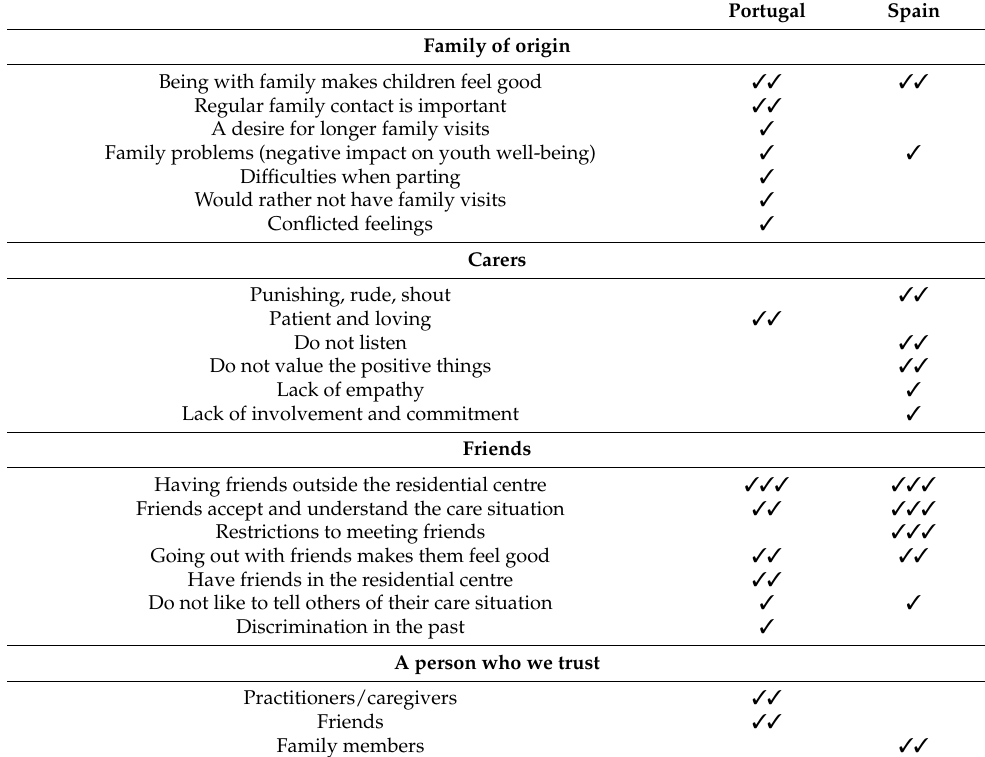
Table 4. Description of subcategories about ‘Interpersonal relationships’ by countries.